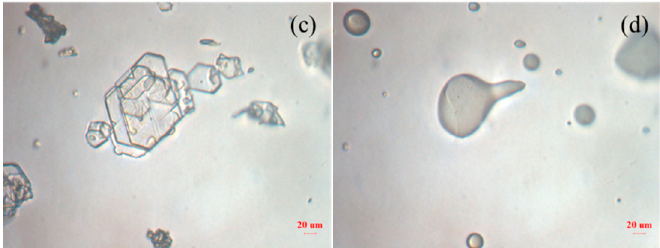
Figure 8. Images obtained by the hot-stage at different temperatures: ( a ) 298.15 K; ( b ) 369.15 K; ( c ) 390.15 K; ( d ) 416.15 K.